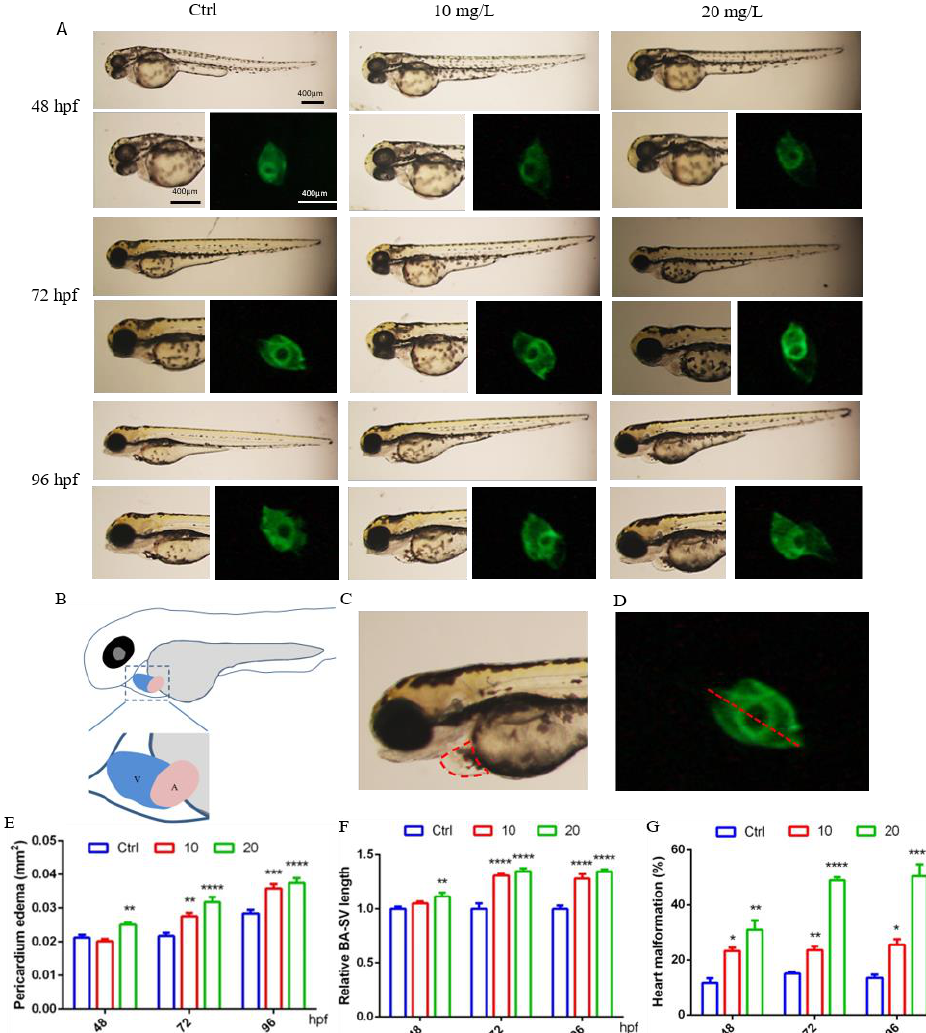
Figure 1. 6-BA induced malformation of zebrafish heart development. ( A ) Cardiac developmental status and fluorescence images of zebrafish larvae at different stages under 6-BA exposure. ( B ) Schema of the atria and ventricular position. ( C ) Schematic diagram of measurement area of pericardial edema area. ( D ) Representative diagram of the measured BA – SV length. ( E – G ) Statistical analysis of pericardial edema area ( E ), BA – SV distance ( F ), and cardiac malformation rate ( G ) in zebrafish over time. Values are expressed as mean ± standard error (SEM). N = 3. * p < 0.05, ** p < 0.01, *** p < 0.001, **** p < 0.0001. Through video processing and image analysis, we found that 6-BA had little effect 10 mg/L 6-BA group were similar to the control, and 20 mg/L only induced a small de-